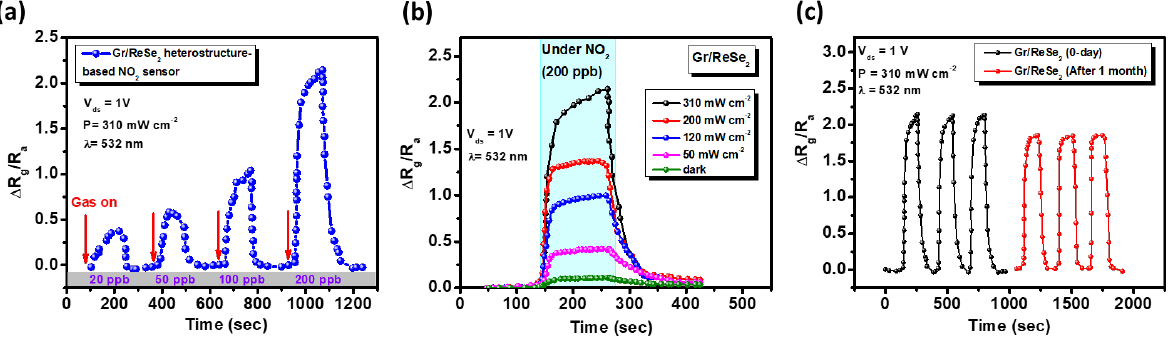
Figure 7. ( a ) Dynamic response of Gr/ReSe 2 heterostructure under NO 2 exposure with different concentrations at V ds = 1V and laser light (532 nm) of power intensity 310 mW cm − 2 . ( b ) NO 2 (200 ppb) gas sensing response of heterostructure under light wavelength (532 nm) exposure with increasing power intensity. ( c ) Heterostructure stability assessment under NO 2 (200 ppb) with laser light (532 nm) intensity of 310 mW cm − 2 . The black curve (0-day) indicates the gas sensing performance of freshly prepared heterostructure, whereas the red curve demonstrates heterostructure performance after one month under ambient Table 1. Comparison of photodetector performance of as-prepared FL-ReSe 2 and Gr/ReSe 2 -HS with other reports from the literature.